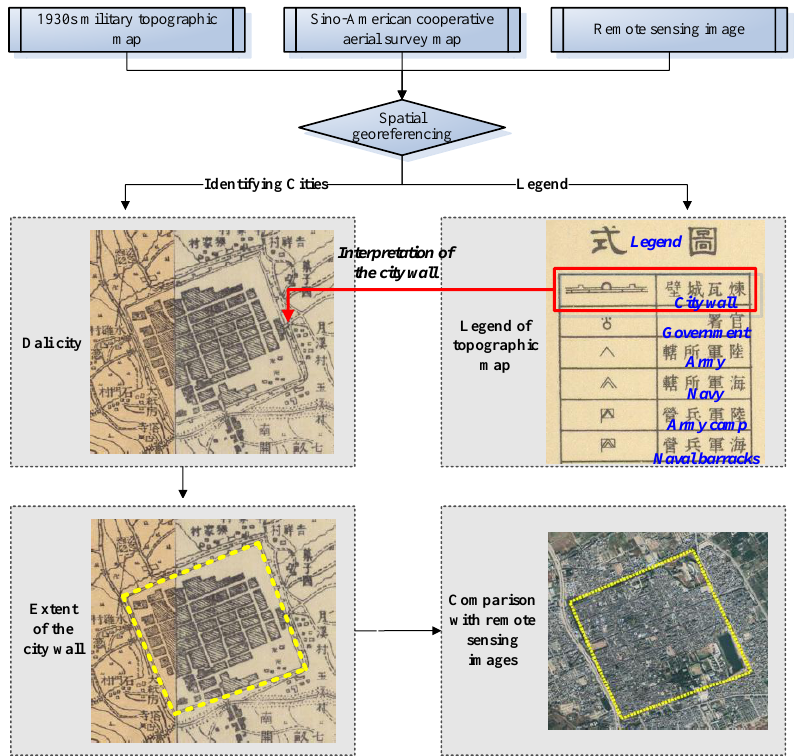
Figure 3. GIS reconstruction workflow on city extent in TCE.